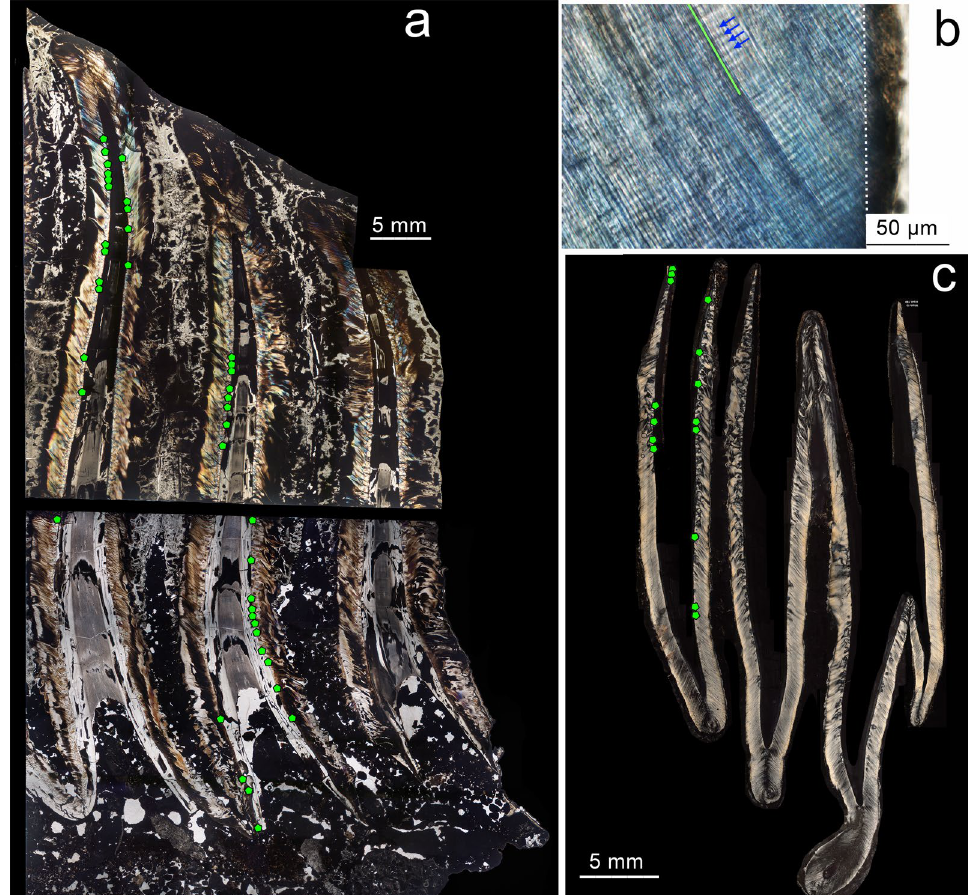
Figure 7. Molar histology of P. falconeri . ( a ) Composed slide of the third lower molar (CAT-114, slides IPS 96,003). The tooth is cut horizontally (3 mm lost); it shows the measured plates 8 and 9 (plate 10 was taphonomically heavily cracked and not measurable) with the location of our measurements (green dots). Depending on the state of preservation of each plate, we took 29 measurements on the upper and 25 on the lower half (there are less points because some of them are too close together as to be separated). ( b ) (slide IPS 85787_3a) illustrates cross striations (blue arrows) along an enamel prism (green), and the enamel-dentine junction (dotted white line) in a lower second molar. ( c ) unworn Dp4/superior (slide IPS-85040; Supplementary material 7) with green dots signaling location of 16 measurements (there are less points because some of them are too close together as to be separated). Zeiss Scope A1 microscope with integrated digital camera (AxioCam ICc5).